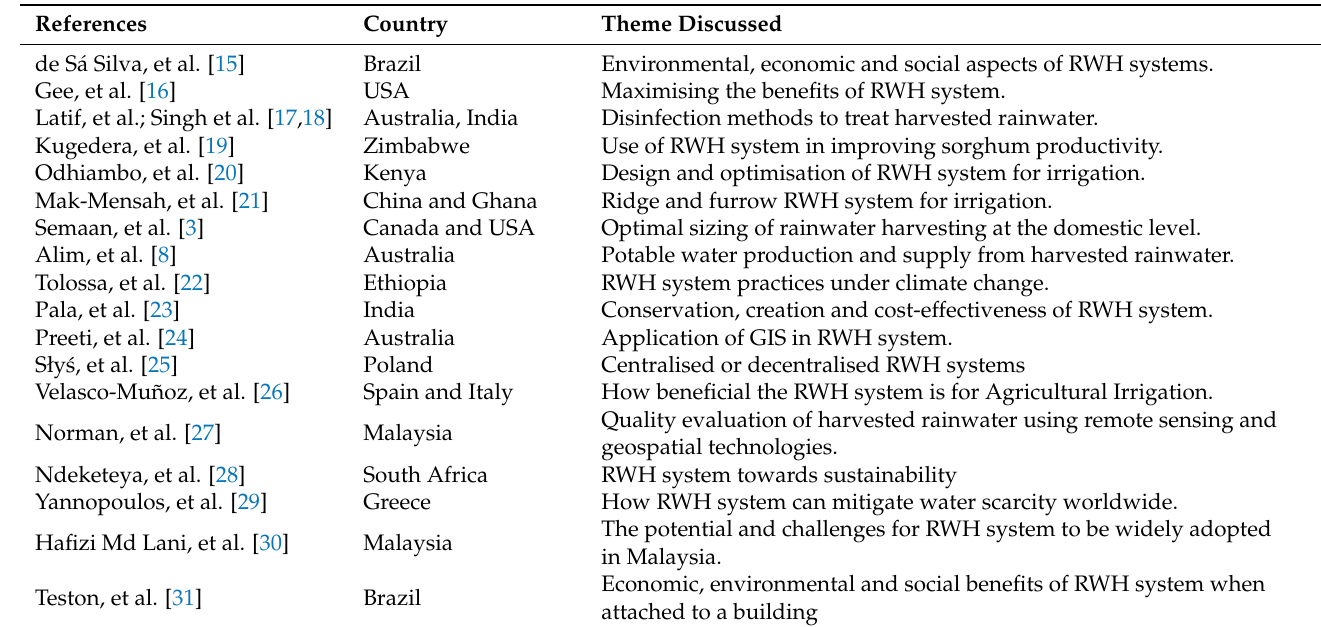
Table 1. Literature review articles published recently on